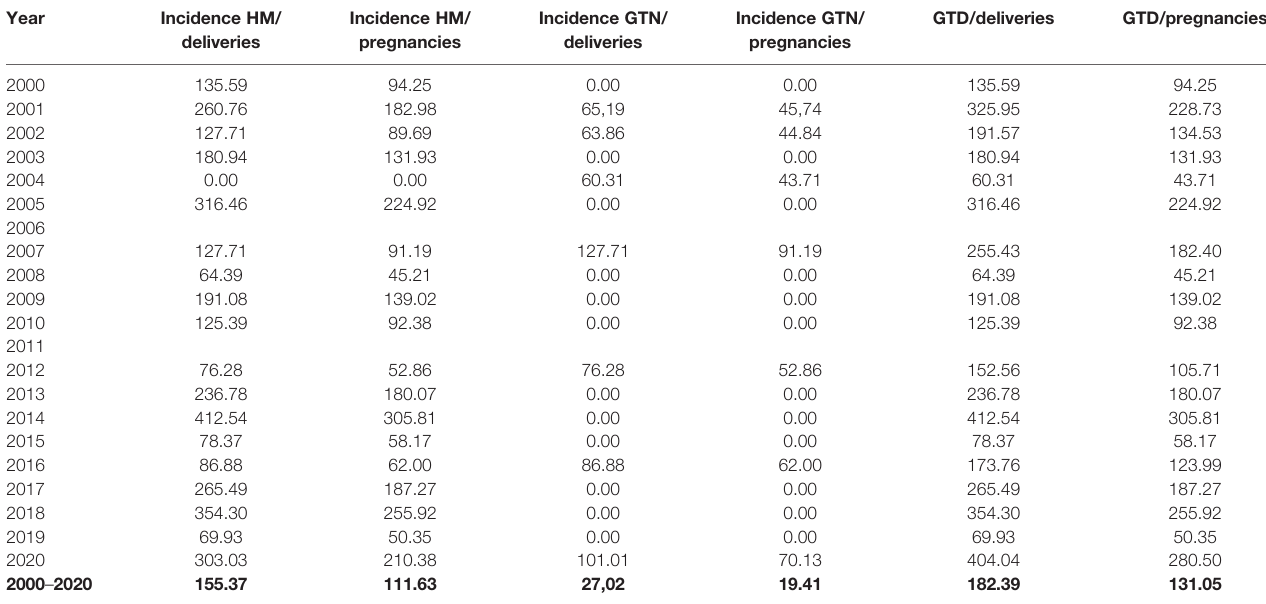
TABLE 1 | Incidence of gestational trophoblastic disease (GTD) x 100000 deliveries and x 100000